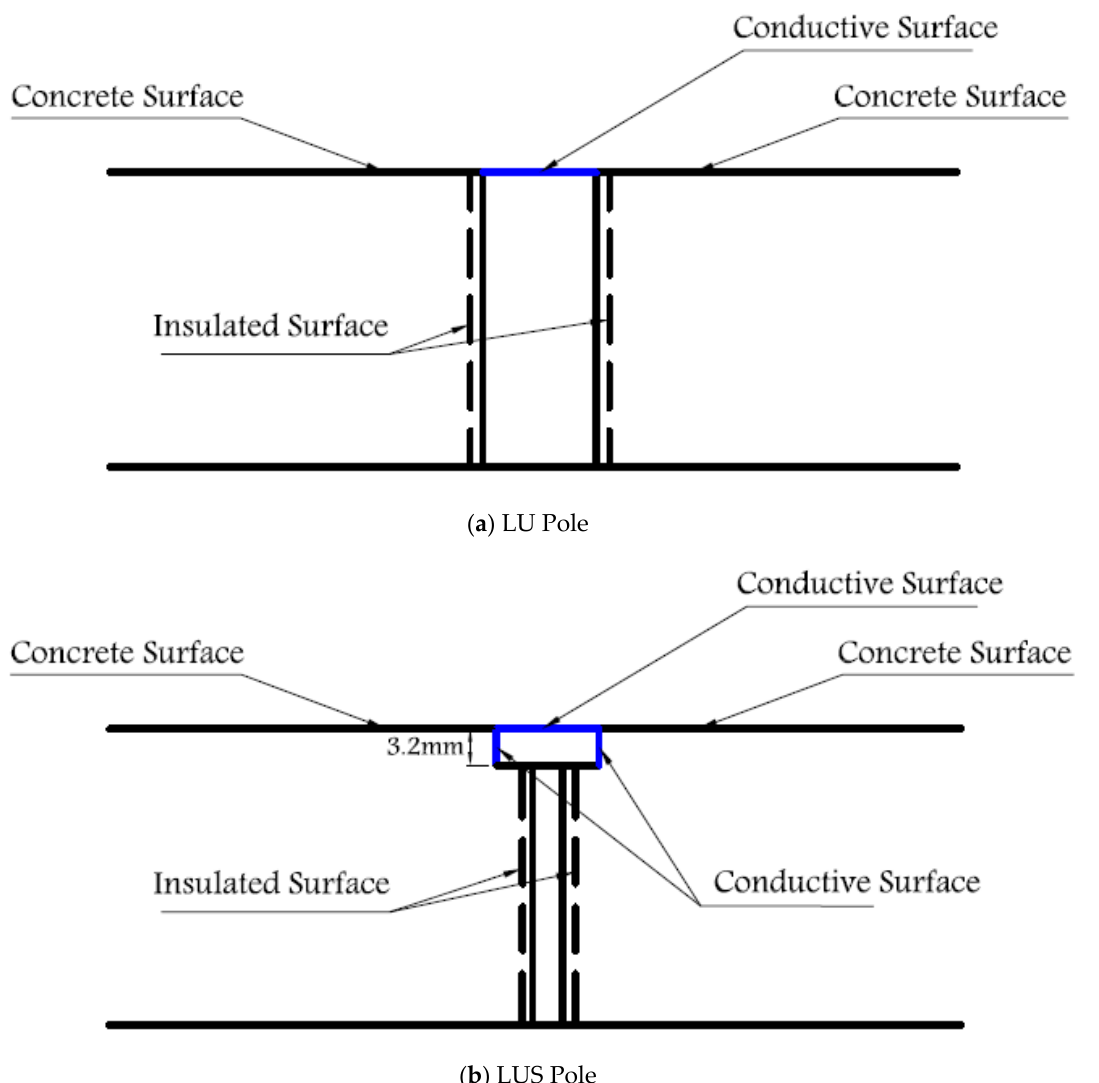
Figure 3. Pole details: ( a ) LU; ( b ) LUS.